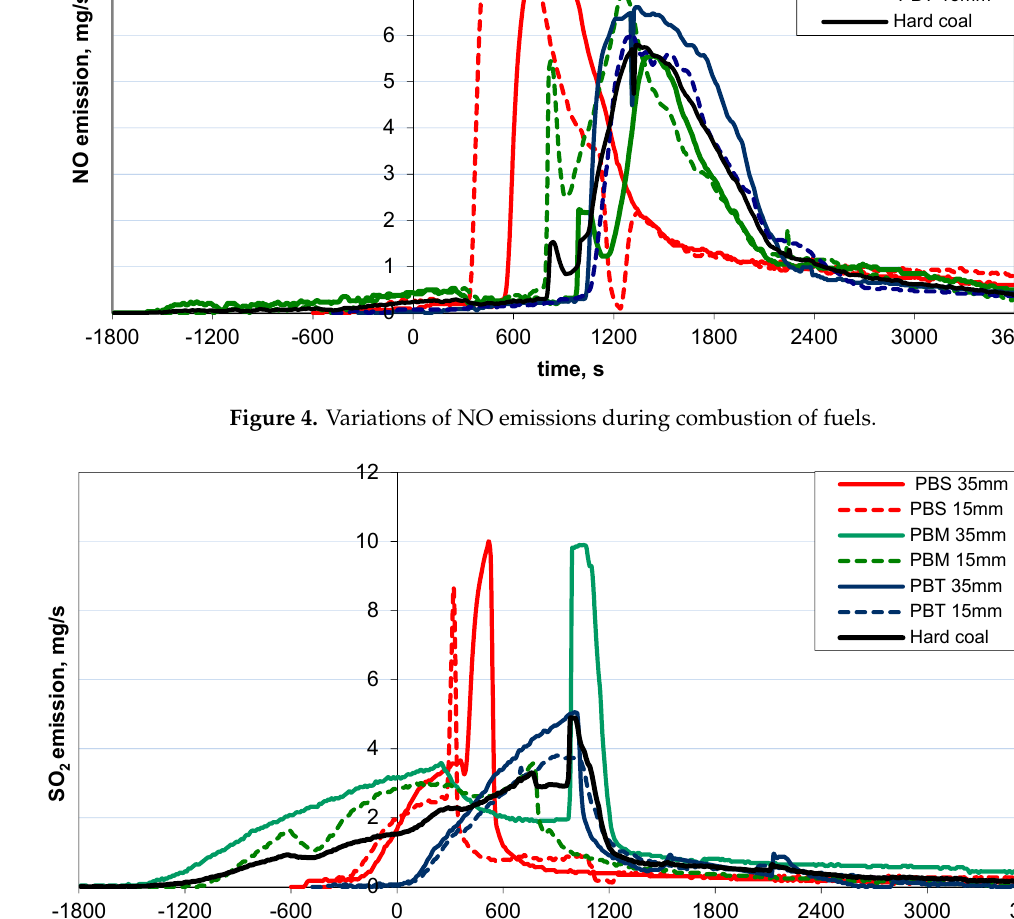
Figure 5. Variations of SO 2 emissions during combustion of fuels.